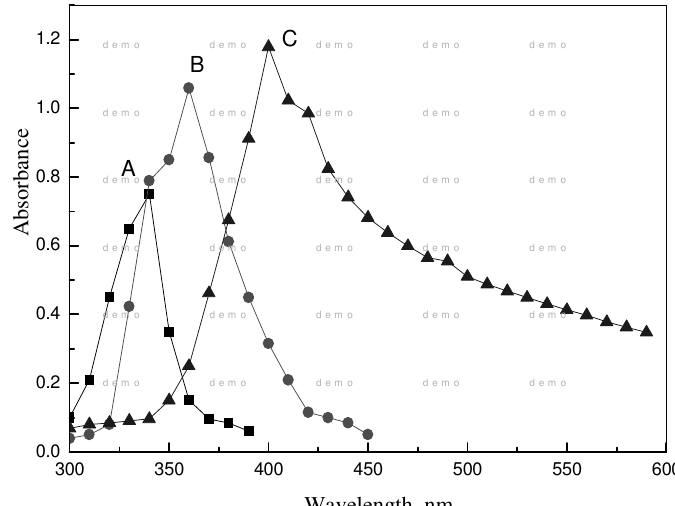
Figure 2. (A) Absorbance spectra of 3,4 – DHBINH vs . blank, (B) Absorbance spectra of V(V)–3,4-DHBINH complex vs . reagent. (C) Absorbance spectra of Cr(VI)–3,4-DHBINH complex vs . reagent V(V)=Cr(VI)= 1mL of 1.0( x )10 −4 mol.L −1 ; pH: 4.0 mL of 5.5; 3,4 – DHBINH: 1.0 mL of 1.0( x )10 −3 mol.L −1